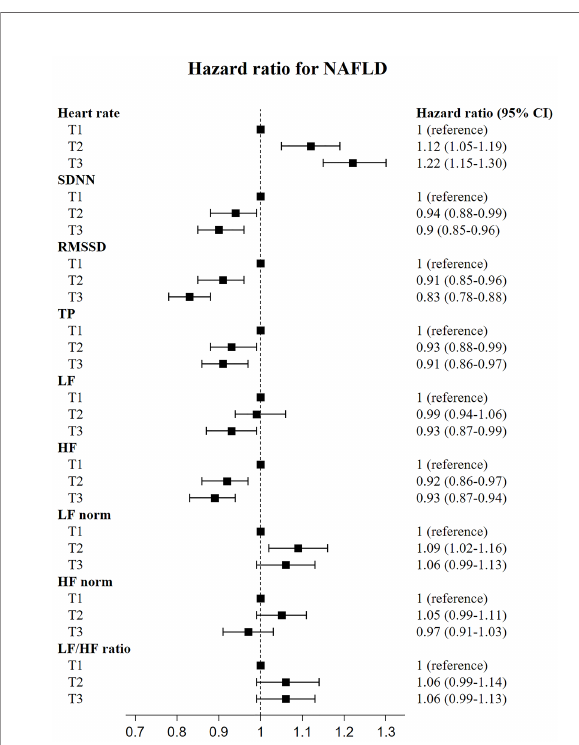
FIGURE 1 | Risk of incident non-alcoholic fatty liver disease according to tertiles of heart rate variability indices.